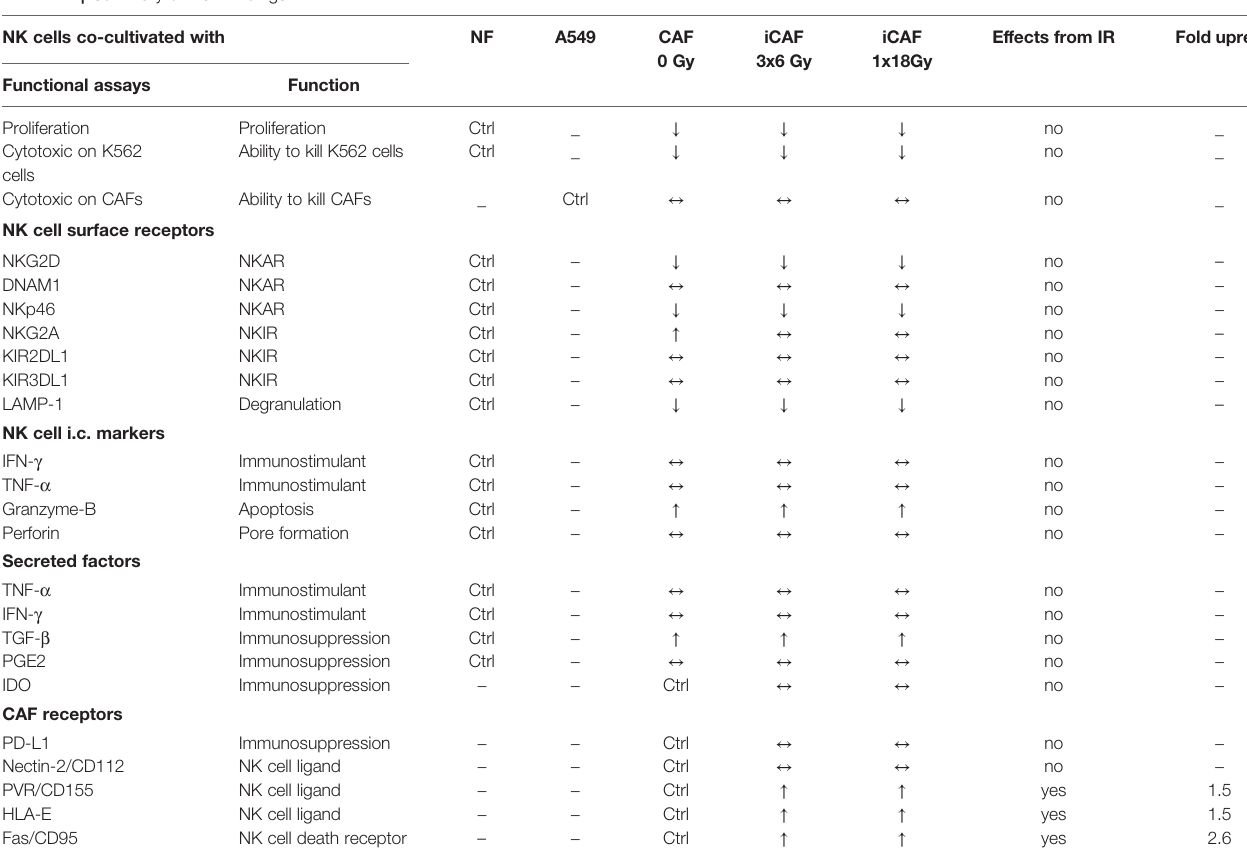
TABLE 2 | Summary of main fi ndings. NK cells co-cultivated